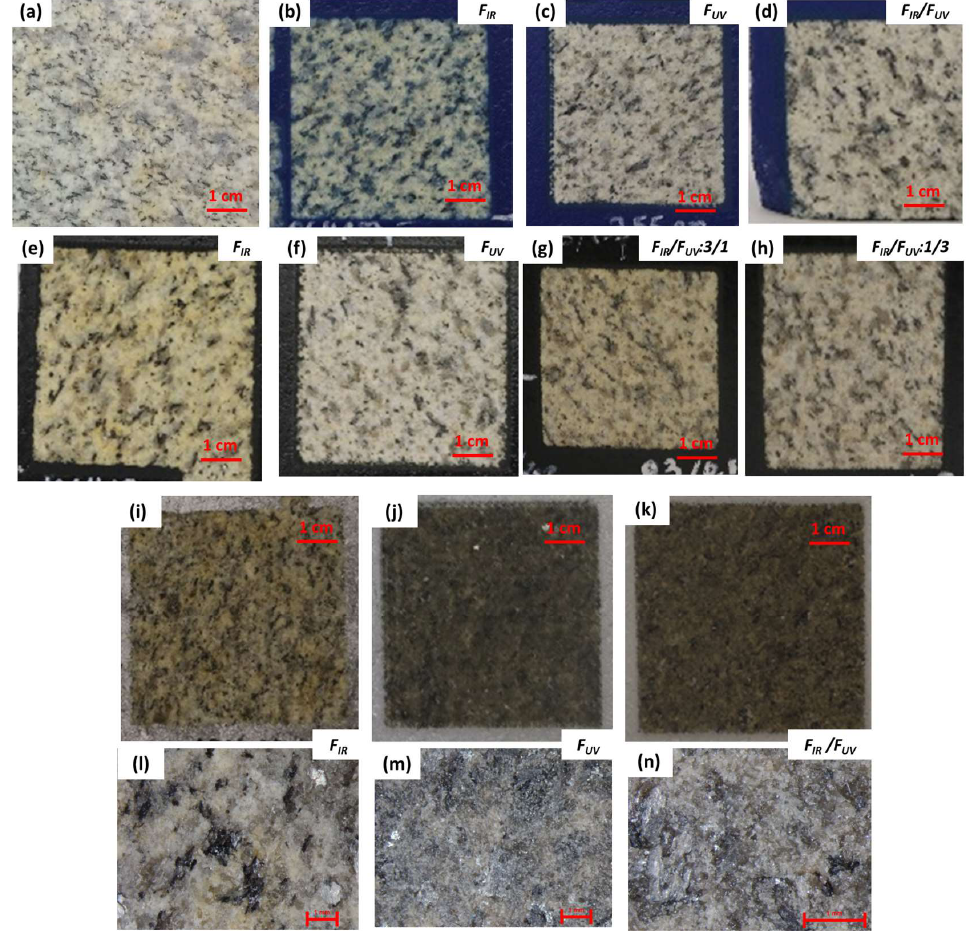
Figure 4. Digital photographs (scale bar of 1 cm) of reference granite ( a ); blue ( b – d ); black ( e – h ) and silver ( i – k ) painted samples treated with the selected conditions at 1064 nm (IR), 355 nm (UV) and their combination. Detailed irradiation conditions are shown in Table 2. For silver graffiti, detailed images taken with stereomicroscopy (scale bar of 1 mm) are also shown: 1064 nm ( l ); 355 nm ( m ) and their combination ( n ) (For interpretation of the references to color, the reader is referred to the web version of this article).